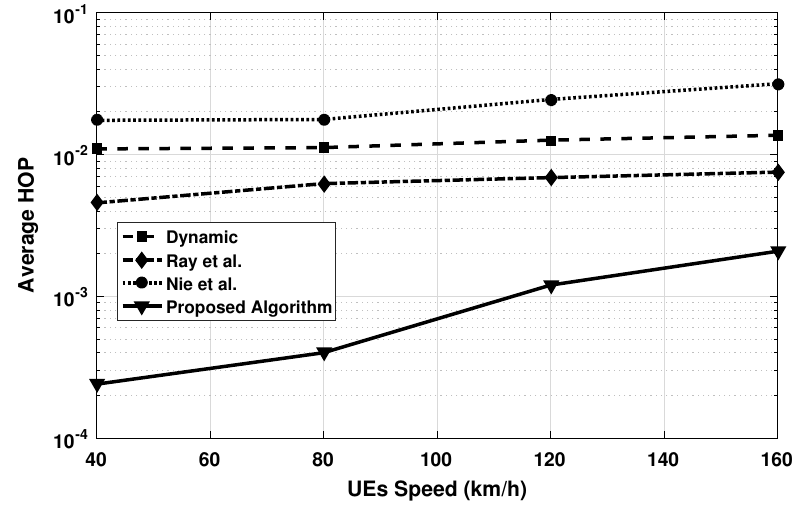
Figure 6. Average HOP with varying UE speeds.